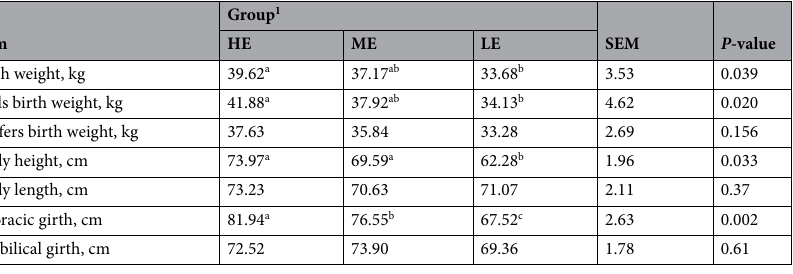
Table 3. Effects of prepartum maternal energy density on birth weights and measurements in neonatal calves. 1 HE = high energy (NEm = 1.67 Mcal/kg of DM); ME = medium energy; (NEm = 1.53 Mcal/kg of DM); LE = low energy (NEm = 1.39 Mcal/kg of DM). a,b ,c Means bearing different superscripts in the same row difer significantly (P < 0.05).